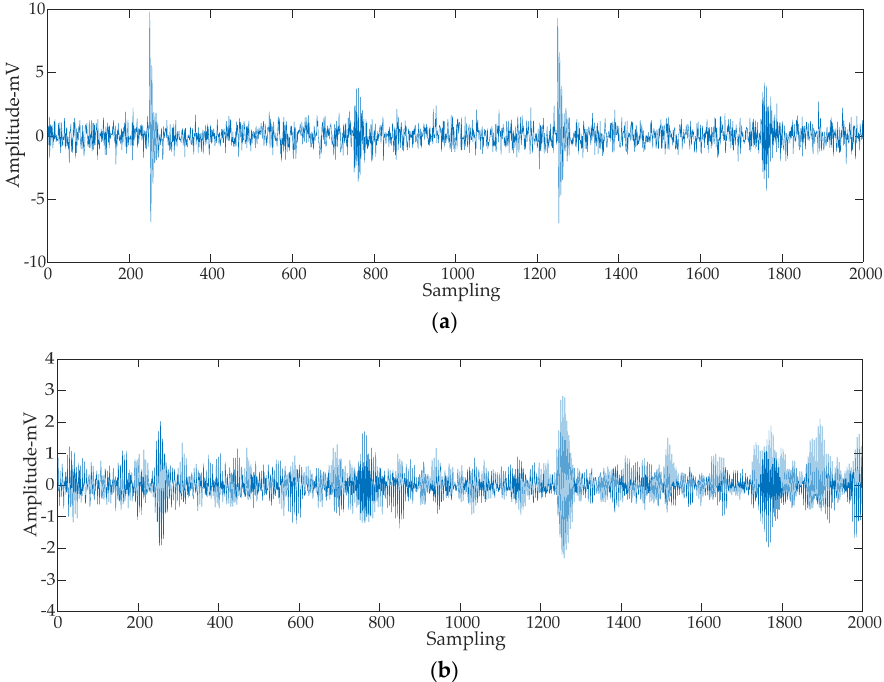
Figure 8. Removal of periodic narrowband interference by PD signal superimposed with white noise. ( a ) Periodic narrowband interference suppression. ( b ) White noise interference